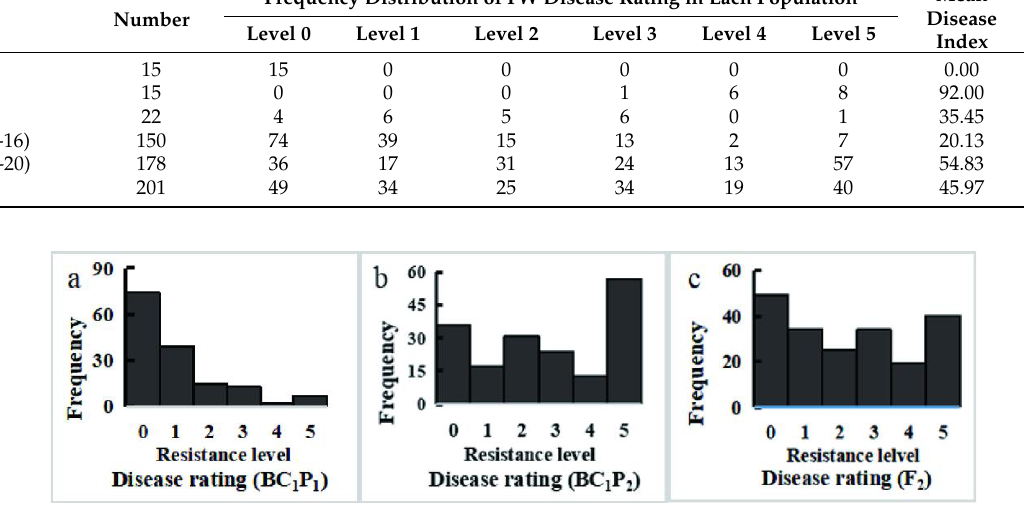
Figure 3. Frequency distribution of the CFW resistance in BC 1 P 1 , BC 1 P 2 , and F 2 . ( a ) BC 1 P 1 , ( b ) BC 1 P 2 , and ( c ) F 2 populations of ‘BI - 16’ × ‘01 - 20’.